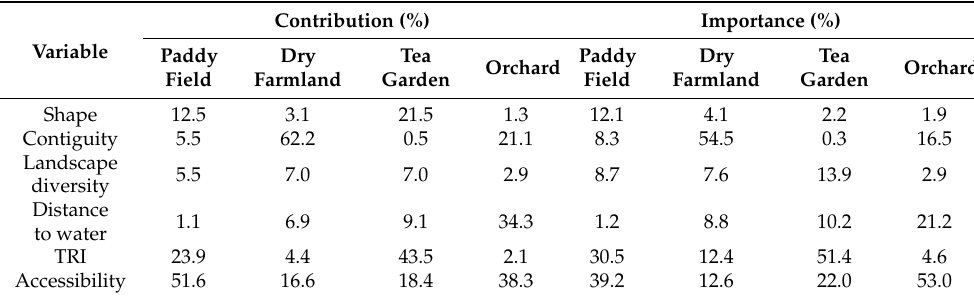
Table 4. Each variable’s contribution rate and importance for estimating the CES flow in different land use types.